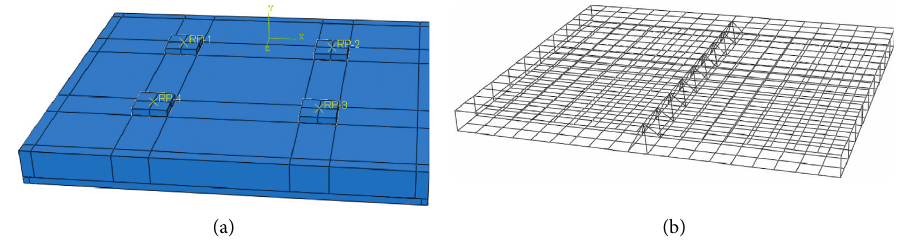
Figure 11: Finite element structural model: (a) concrete panel; (b) steel rack.